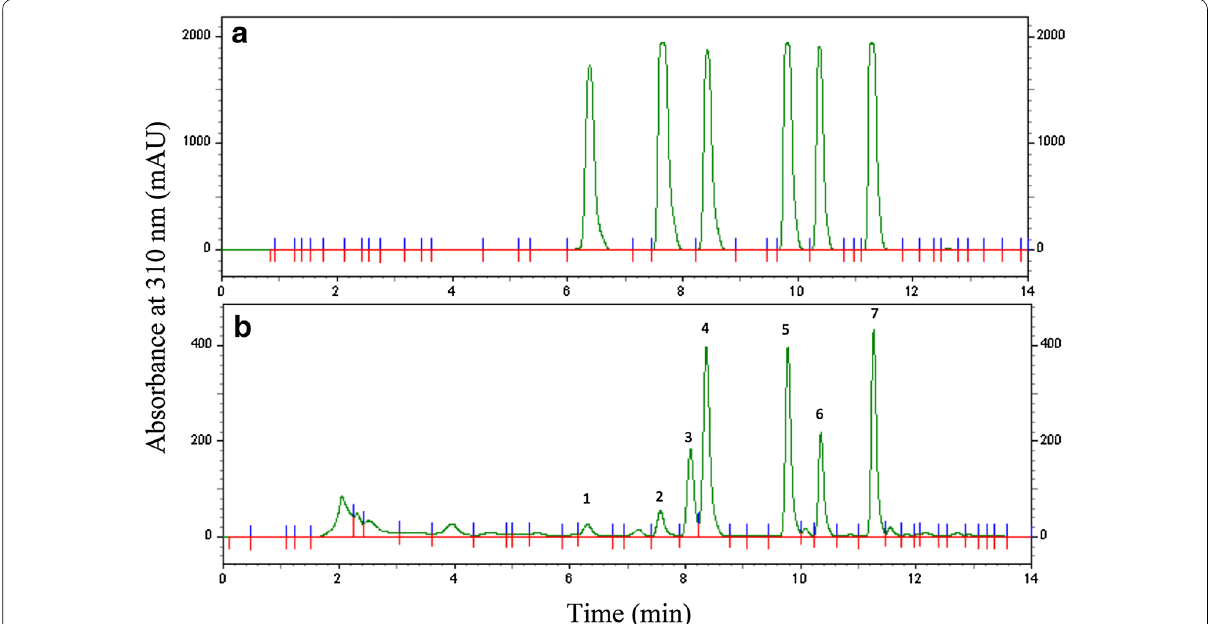
Fig. 3 HPLC‑DAD chromatogram of standard ( a ) compared with Baizhi root tissue ( b ). Peaks 1, 2, 4, 5, 6 and 7 were identified as xanthotoxin, ber‑ gapten, oxypeucedanin, imperatorin, phellopterin and isoimperatorin,